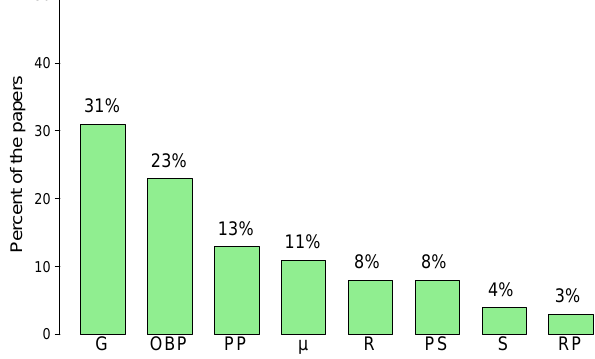
Figure 6. Variables of the seawater carbonate system reported in the papers. 6 Measured parameters